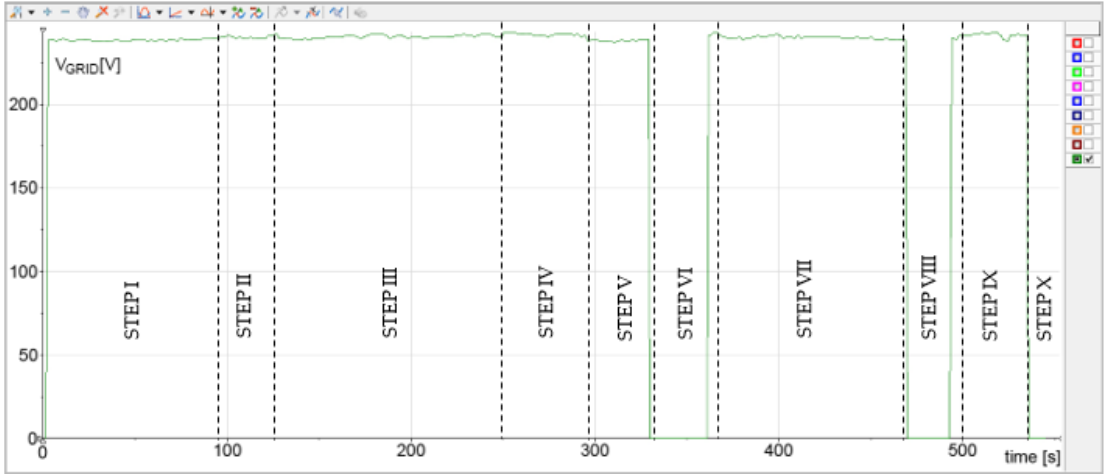
Figure 10. RMS AC voltage of PEI converter.